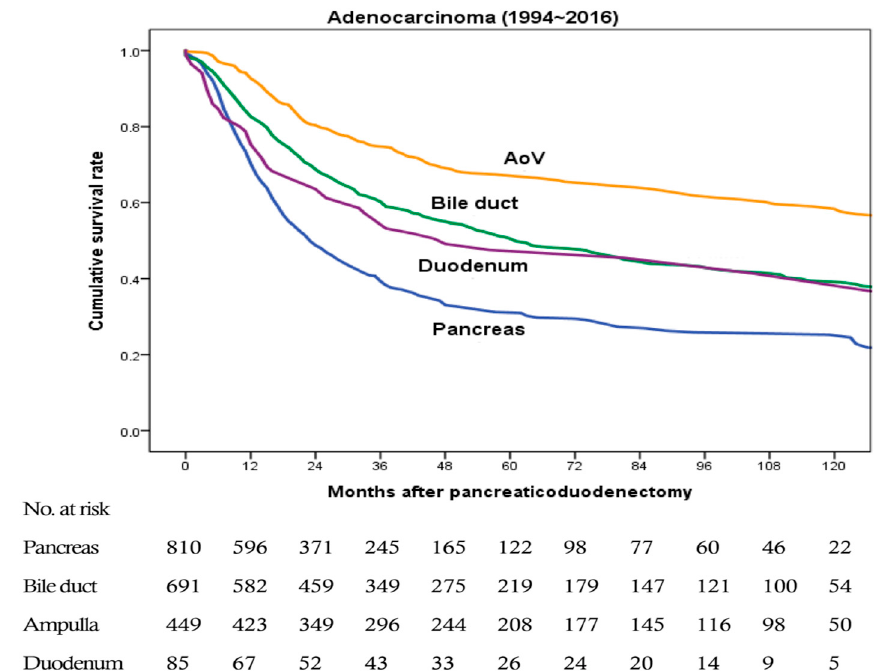
Figure 2. Overall survival rates of patients with pancreatic, bile duct, ampullary, and duodenal adenocarcinomas from 1994 to 2016 (a total 2035 cases, 810, 691, 449, and 85 cases, respectively). Pancreatic vs. bile duct, p < 0.001; pancreatic vs. ampullary, p < 0.001; pancreatic vs. duodenal, p = 0.025; bile duct vs. ampullary, p < 0.001; bile duct vs. duodenal, p = 0.278; and ampullary vs. duodenal, p < 0.001.